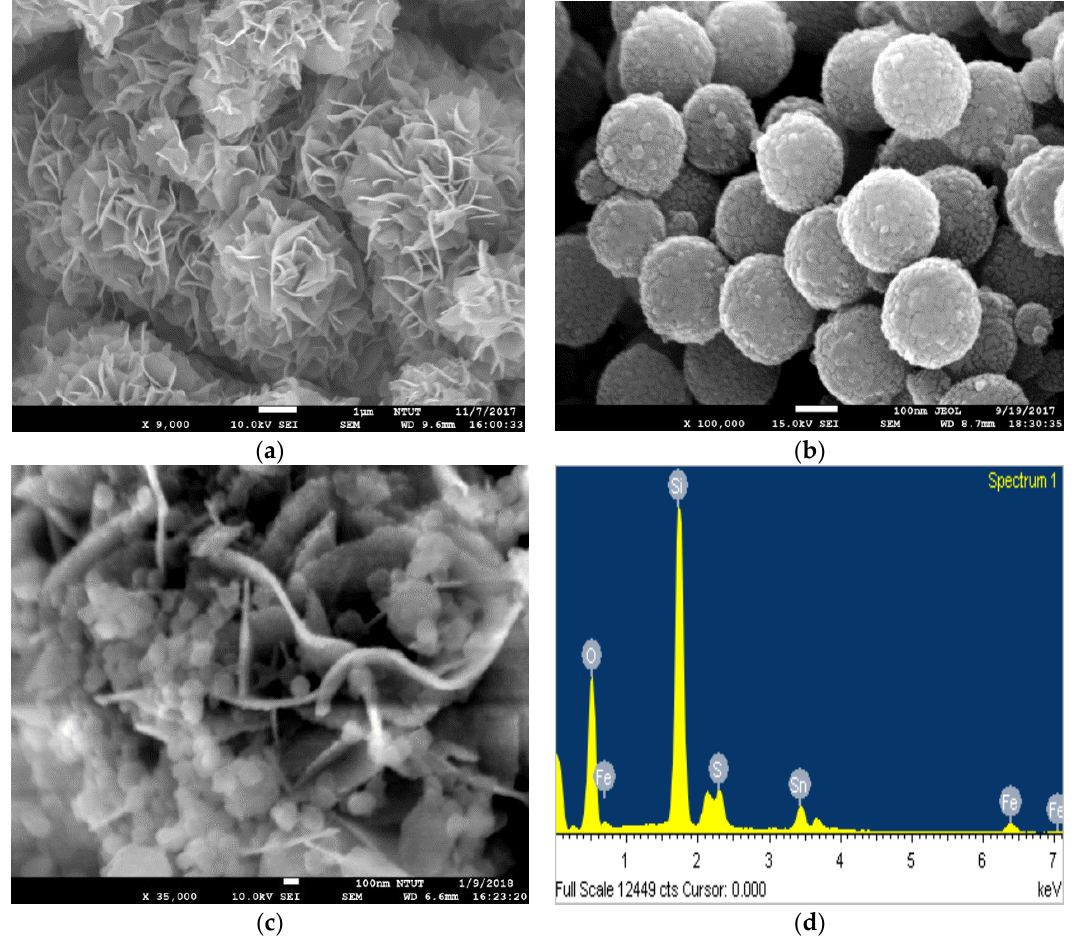
Figure 2. FE-SEM images of ( a ) Flower-like SnS 2 , ( b ) SiO 2 @α -Fe 2 O 3 nanocomposites, ( c ) SnS 2 -SiO 2 @α -Fe 2 O 3 nanocomposite, and ( d ) EDX spectra corresponding to a SnS 2 -SiO 2 @α -Fe 2 O 3 nanocomposite.